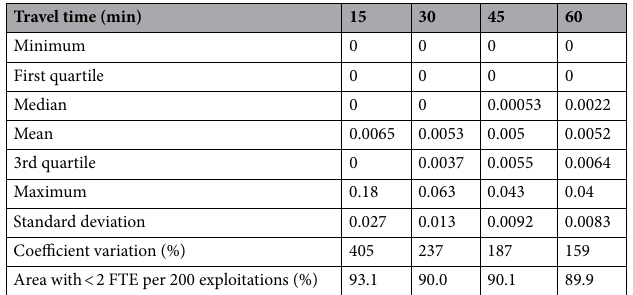
Table 2. 2SFCA accessibility index distribution based on 4 travel time distances.